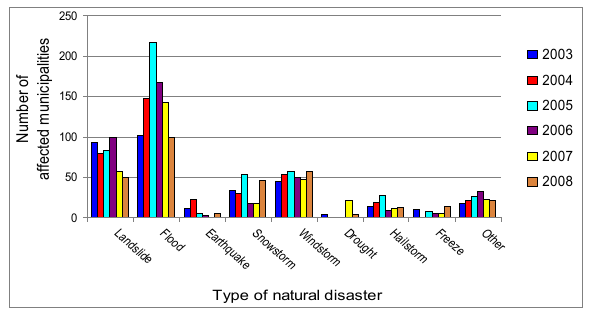
Figure 3. Number of municipalities affected by various disasters per year for the period 2003